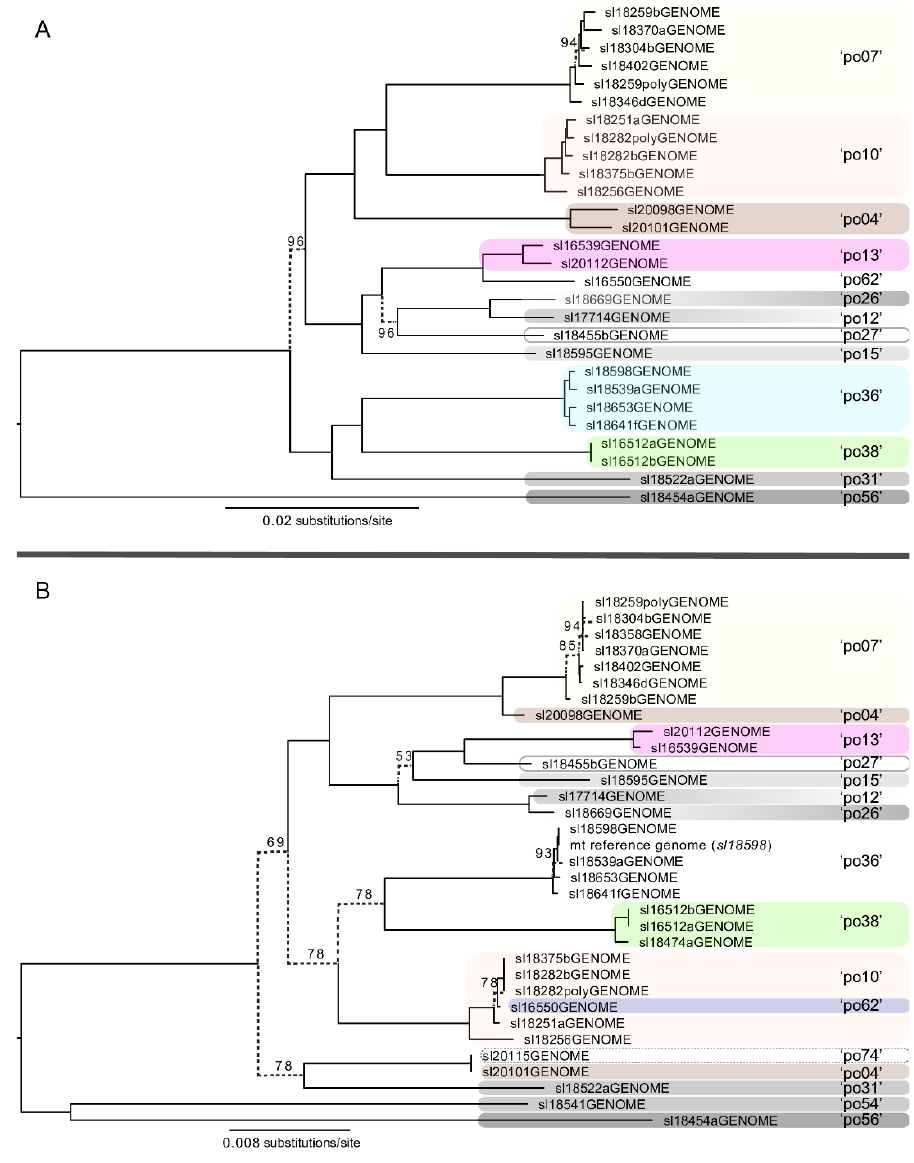
Figure 4. Maximum likelihood (ML) topologies inferred from nuclear ( A ) and mitochondrial ( B ) phylogenomic datasets. ( A ). A ML topology from the concatenated alignments of 1209